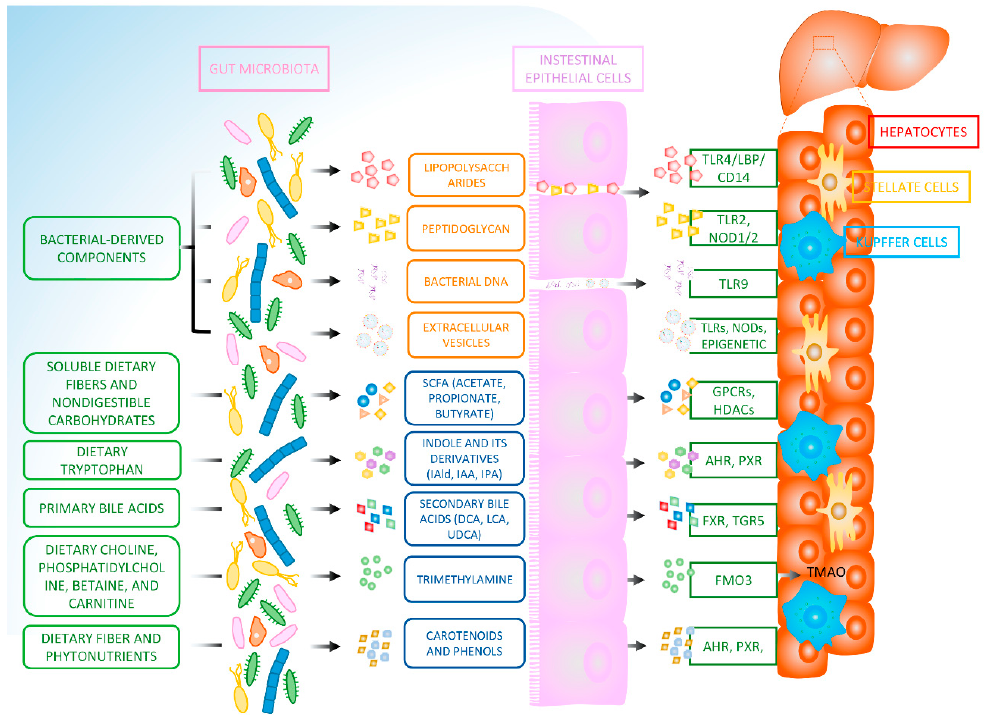
Figure 1. The mechanisms that connect gut microbiome-derived ingredients and metabolites with non-alcoholic fatty liver disease (NAFLD). Impaired intestinal mucosal barrier function leads to leakage of bacterial components (lipopolysaccharides, peptidoglycan, DNA, and extracellular vesicles) from the gut into the portal vein that provides blood to di ff erent liver cell types (Kup ff er cells, hepatic stellate cells, and hepatocytes). These bacterial components result in activation of the corresponding toll-like receptors (TLR2, TLR4, TLR9) or NOD-like receptors (NOD1, NOD2) and the subsequent signaling pathway. The short RNA (sRNA) inside the extracellular vesicles serve as epigenetic regulators in gene expressions. The intestinal microbiome can be subjected to soluble dietary fibers and nondigestible carbohydrates fermentation which produce SCFAs (acetate, propionate, and butyrate). Short-chain fatty acids work through binding to their receptors (GPCRs) or by inhibiting the activity of histone deacetylases (HDACs). Dietary tryptophan is metabolized to indole and its derivatives (indole-3-aldehyde, indole-3-acetic acid, and indole-3-pyruvic acid) by the tryptophanase generated from specific species of gut microbiome, followed with the activation of AHR and PXR signaling in the liver tissue via the portal vein. Primary bile acids (cholic acid (CA) and chenodeoxycholic acid (CDCA)) can be metabolized to secondary bile acids (deoxycholic acid (DCA), lithocholic acid (LCA), and ursodeoxycholic acid (UDCA)) which regulates FXR and TGR5 signaling in the liver. The bacteria that resides in the gut also metabolizes choline into trimethylamine which is oxidized to trimethylamine-N-oxide (TMAO) by hepatic flavin-containing monooxygenases 3 (FMO3). Dietary components (e.g., fiber and phytonutrients) provide substrates for microbiota-derived carotenoids and phenols which act on hepatic tissue directly or via AHR and PXR activation.